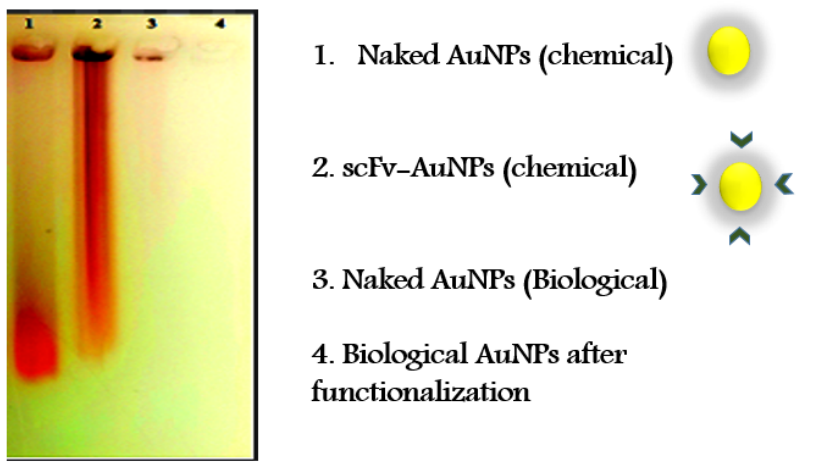
Figure 4. Illustrated immigration pattern of AuNPs in various conditions: 1 the chemically synthe-